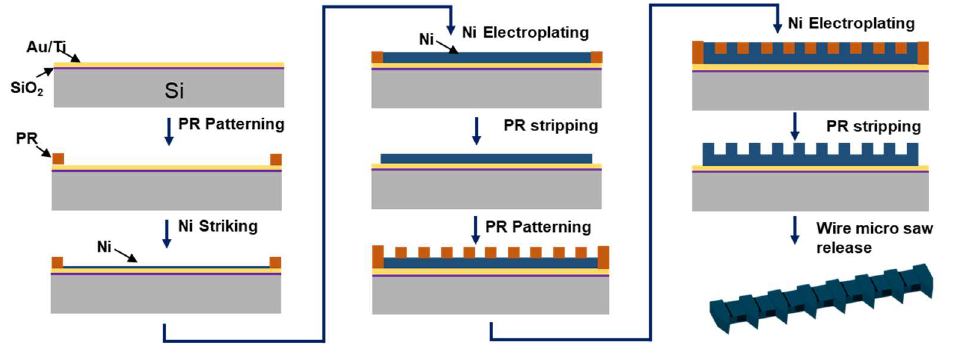
Figure 3. Schematic illustration of micro saw fabrication process.